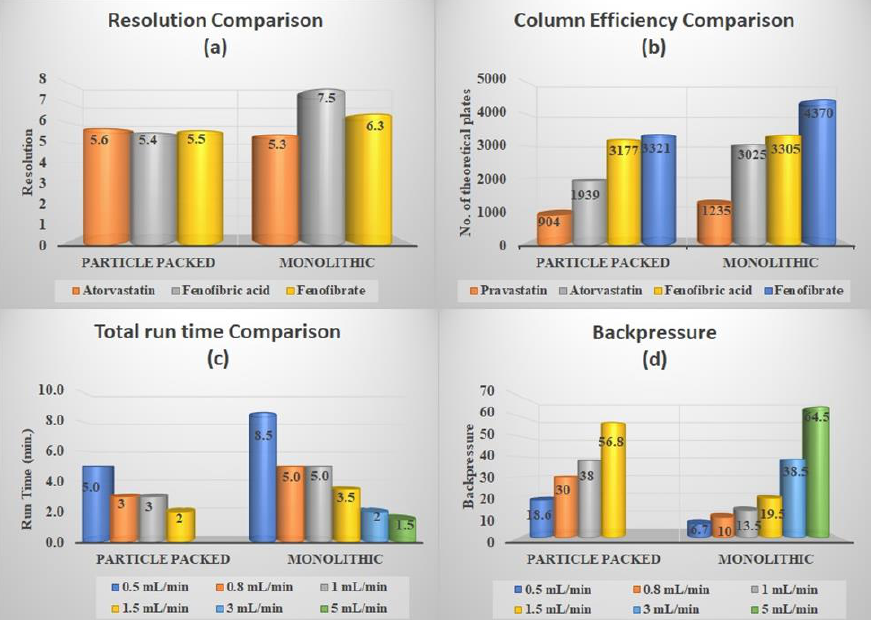
Figure 6. Comparison between the used columns in terms of ( a ) resolution, ( b ) column efficiency, ( c ) total run time, and ( d ) backpressure.